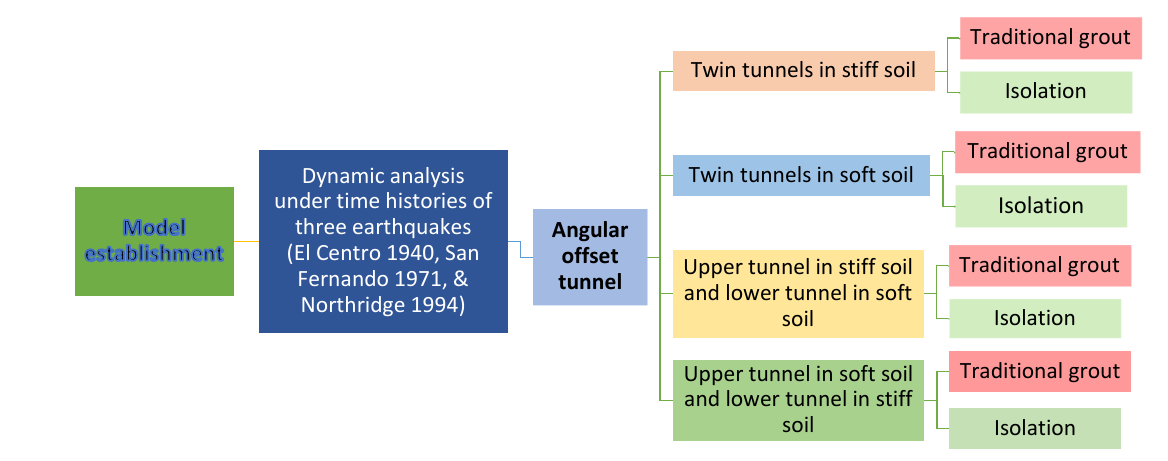
Figure 10. Numerical modeling development flowchart.